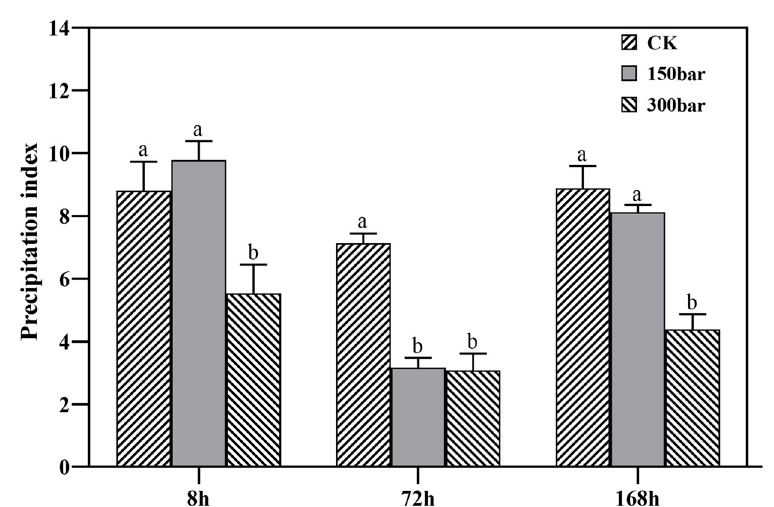
Figure 6. Analysis of the stability of pasteurized milk treated with different homogenization pressures at different time points. a-b represented the significant difference ( p < 0.05) between groups.